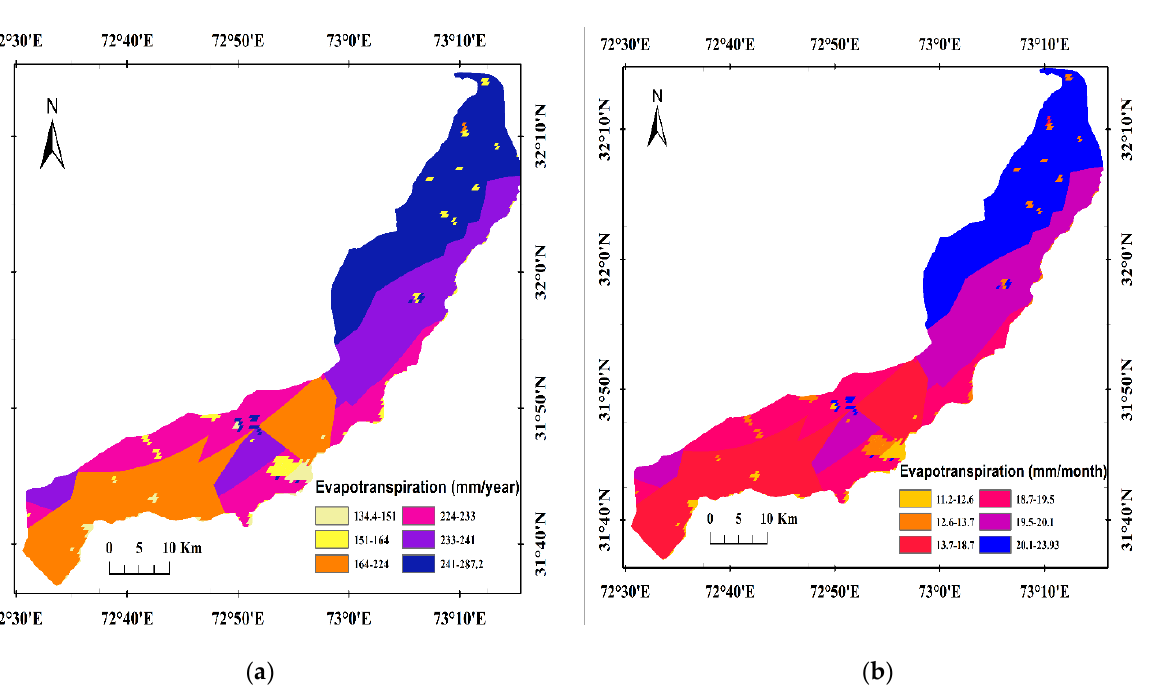
Table 2. Long-term annual, seasonal, and monthly simulated water balance components of the Khadir canal sub-division (2000 – 2019).